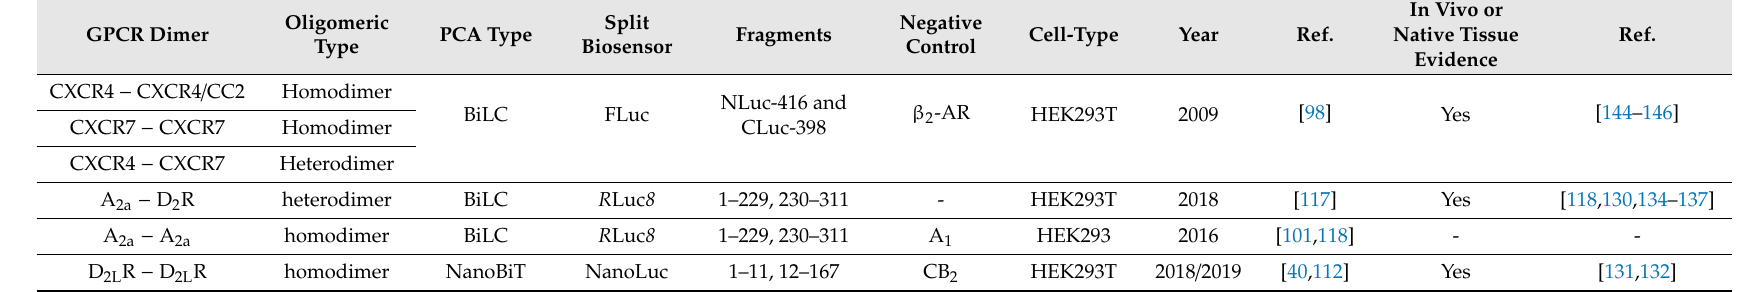
Table 6. An overview of GPCR–GPCR interactions, shown by luminescence complementation